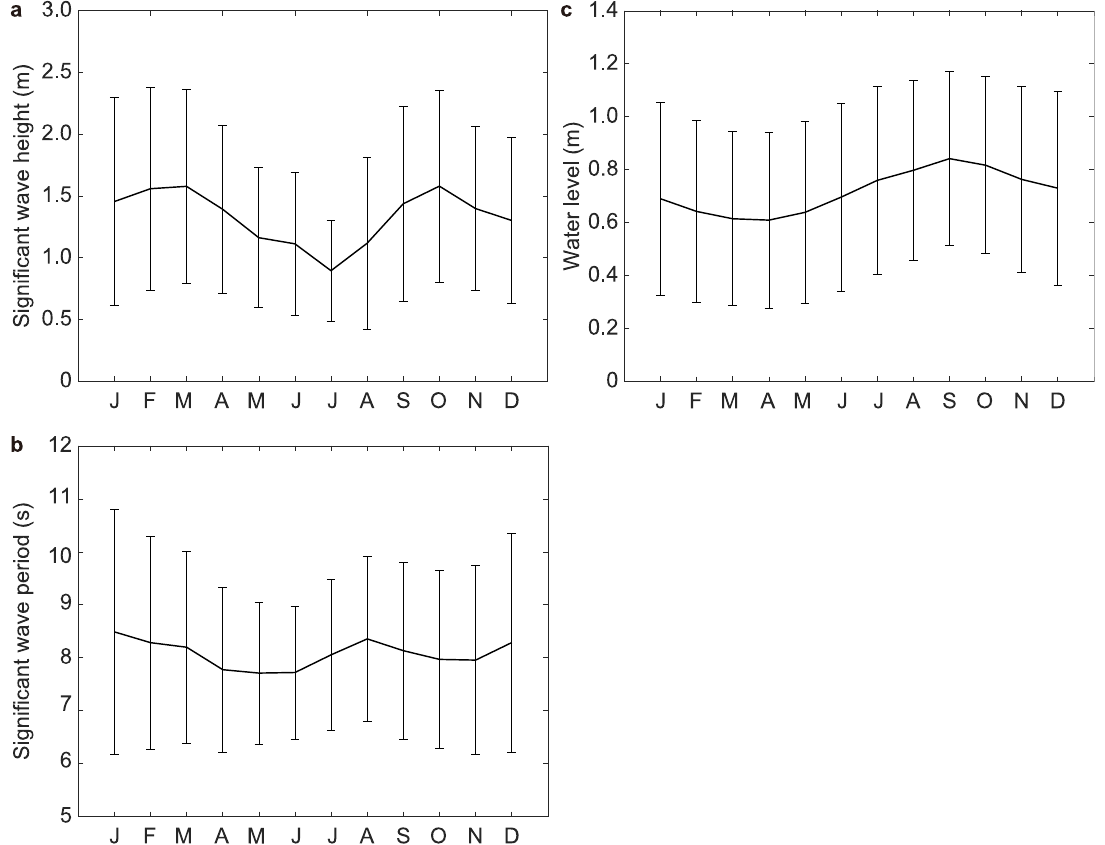
Figure 9. Monthly mean of deepwater significant wave height and period, and water level with ± 1 S.D. ( a ) Significant wave height; ( b ) significant wave period; ( c ) water level.